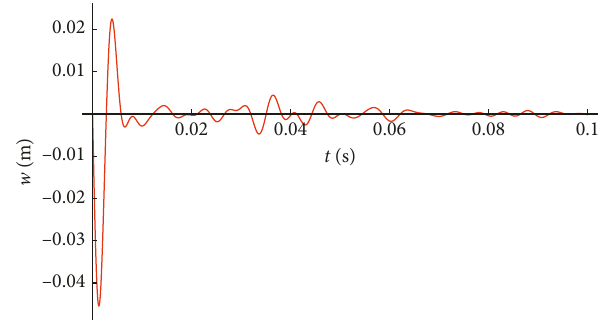
Figure 7: Total displacement time history curve of impact